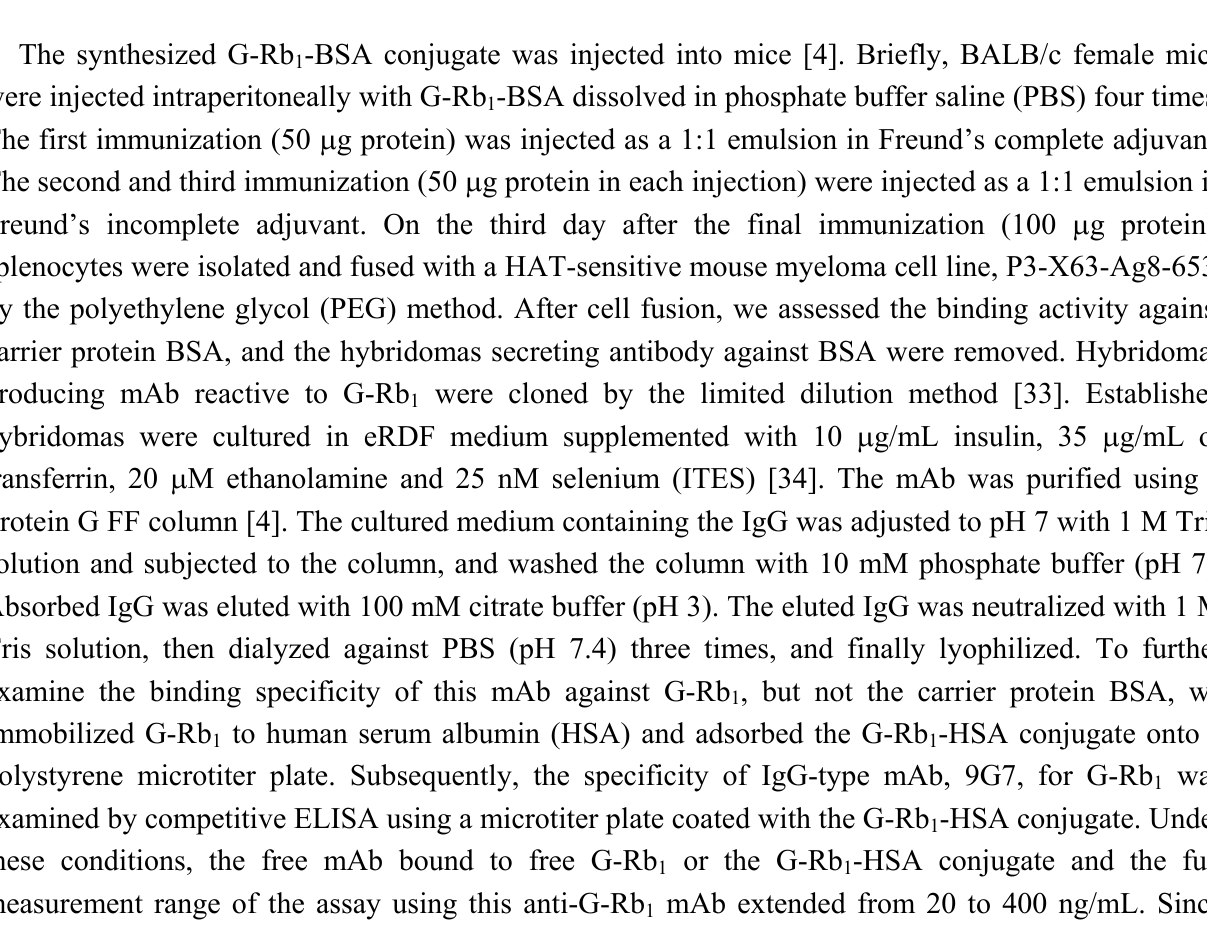
-BSA conjugate. ( b ) Direct detection of G-Rb 1